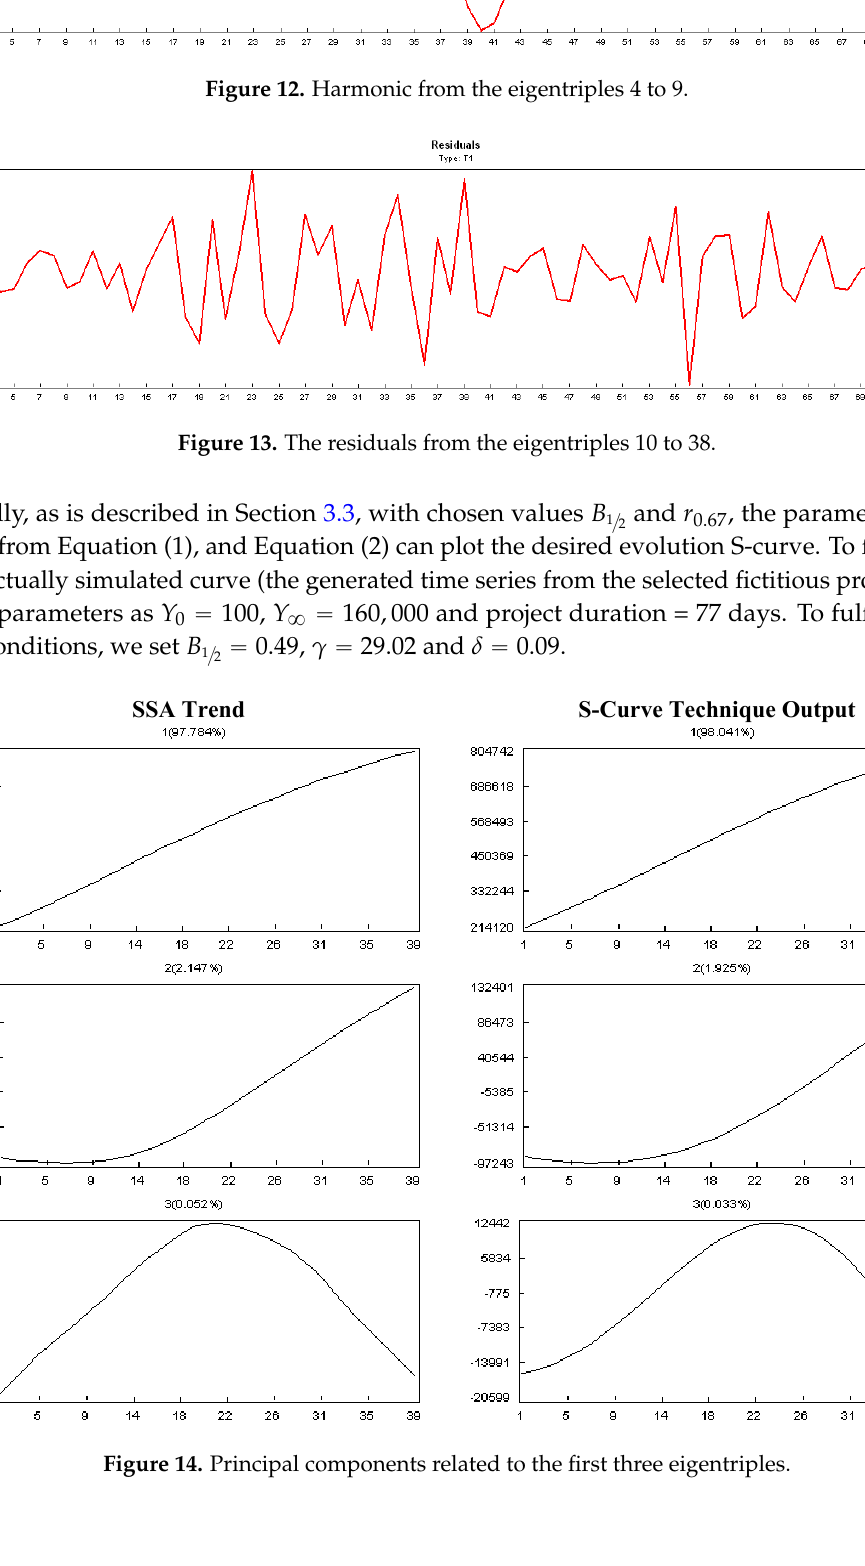
Figure 14. Principal components related to the first three eigentriples. The deviations between the trend of simulated results (SSA trend) and the S-curve technique with the first generated time series are shown in Figure 15. Clearly, these two deviations have the